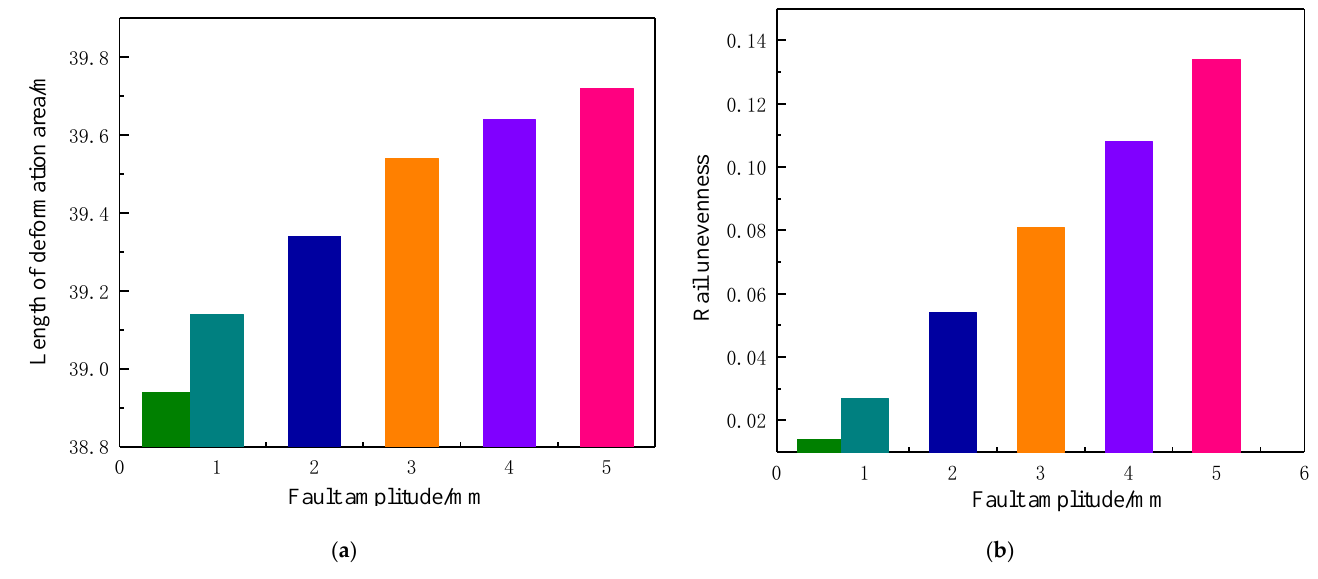
Figure 14. Relationship between length of deformation area and rail unevenness and fault amplitude of the girder. ( a ) Length of deformation area; ( b ) rail unevenness. Table 3. Rail mapping deformation area length and rail unevenness of girder vertical